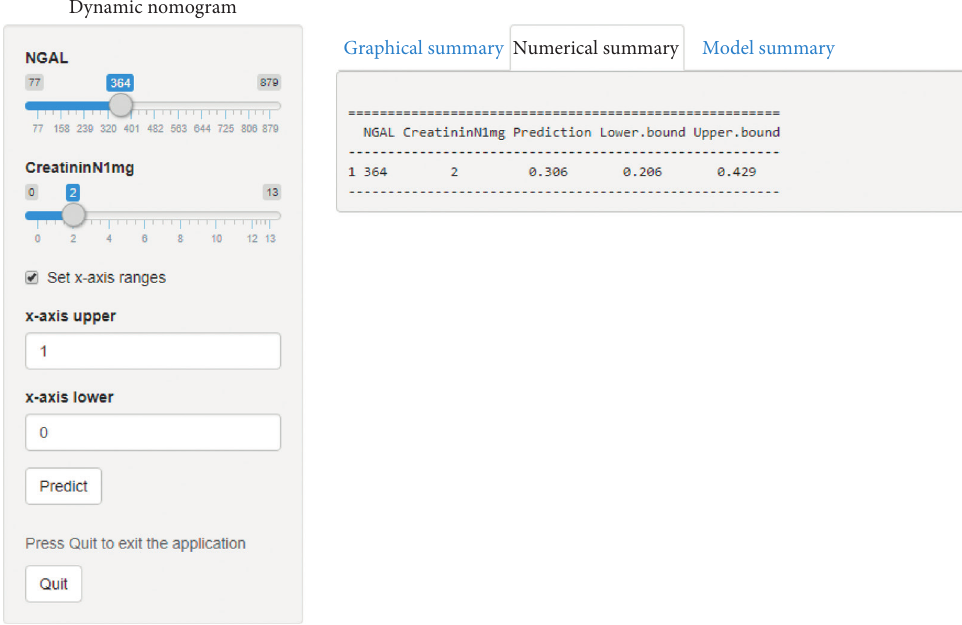
Figure 4: Dynamic nomogram in predicting CRS1 of plasma NGAL and creatinine D1. Figure 3 and model visualisation by dynamic nomogram is shown in Figure 4 (http://127.0.0.1:3540).